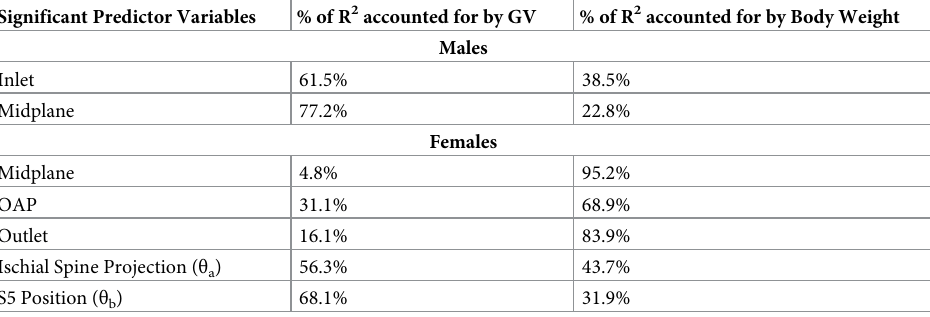
Table 5. Relative importance of predictor variables on canal shape and